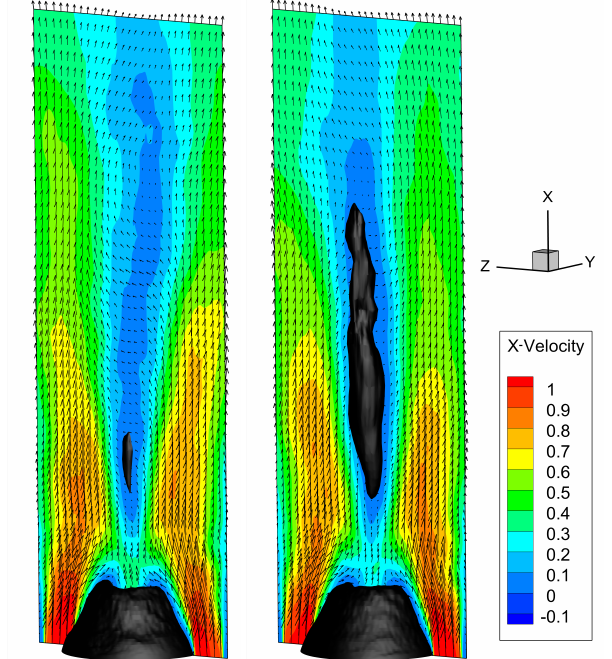
Figure 8. Reconstruction of the axial velocity fields ( m / s ) by 2D ROM using the first mode pair ( St = 0.0307), with a black isosurface of zero axial velocity and the velocity vectors shown. Left : Reconstruction with the minimal temporal coefficient. Right : Reconstruction with the maximal temporal